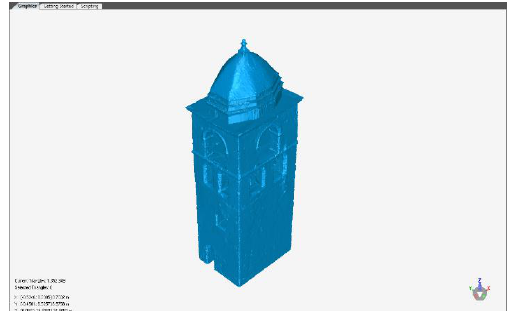
Figure 2. Watertight mesh generated into Geomagic